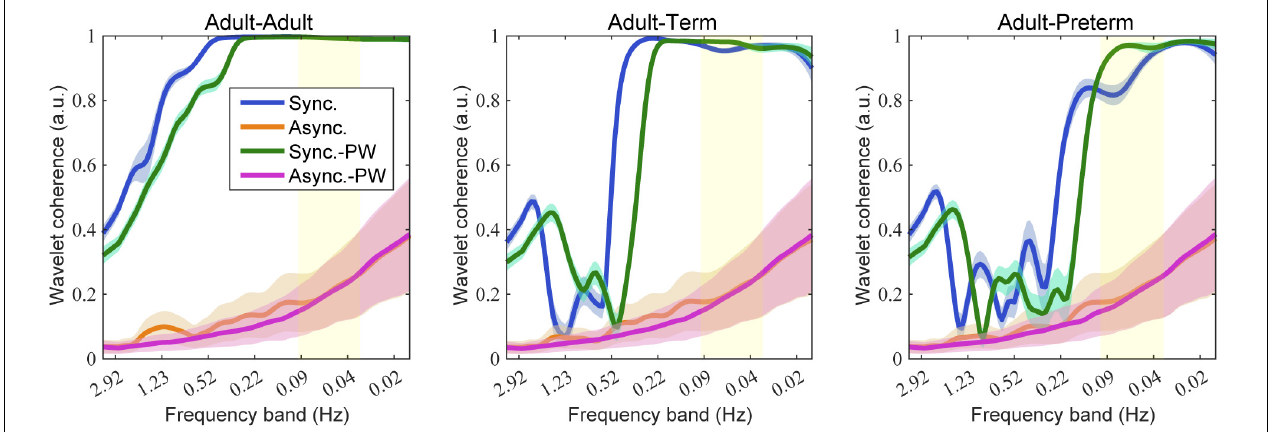
FIGURE 4 | Simulation results of wavelet coherence with 80 social events. The colored lines and areas represent the mean and standard deviation of wavelet coherence, respectively. Blue indicates the synchronized-pair condition, orange indicates the asynchronized-pair conditions, magenta indicates the synchronized-pair condition with prewhitening, and green indicates the asynchronized-pair conditions with prewhitening. The yellow area indicates the targeted frequency bands generally used for wavelet coherence analysis (0.03–0.1